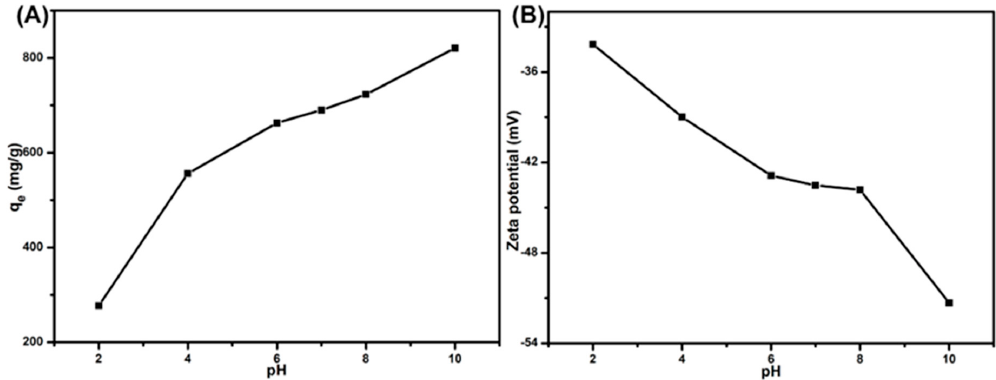
Figure 6. The effect of solution pH on the adsorption of MB onto the SPEN-Al-2 ( A ). Tthe variation of zeta potentials of SPEN-Al-2 versus the solution pH ( B ).